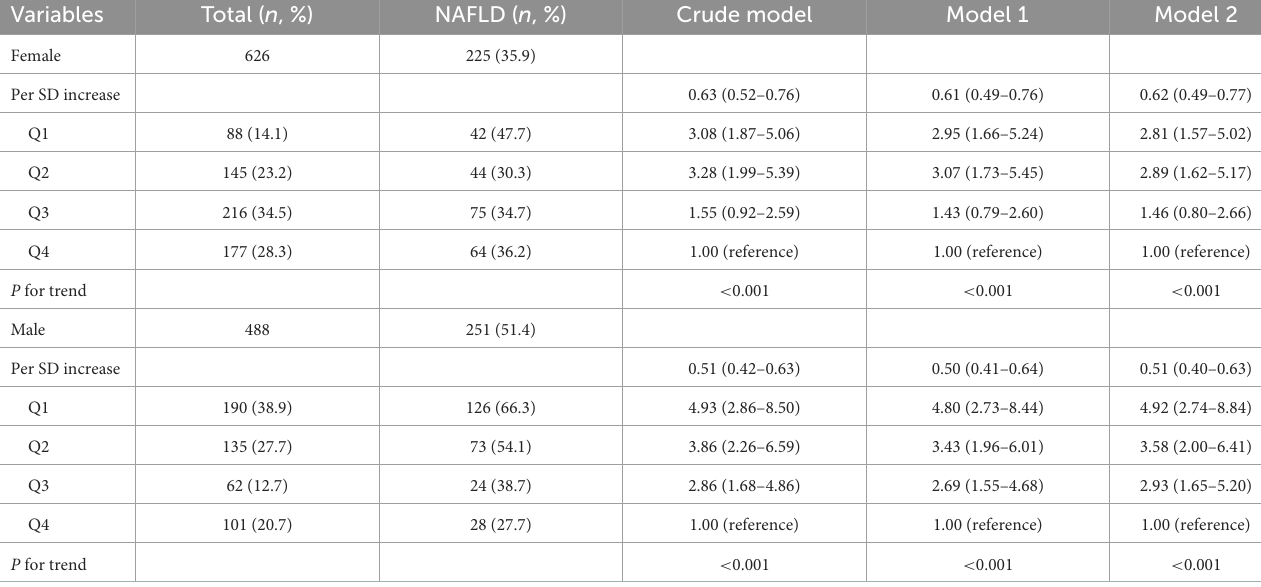
TABLE 2 Gender-specific association between each quartile of ASMI values and risk of NAFLD by gender.